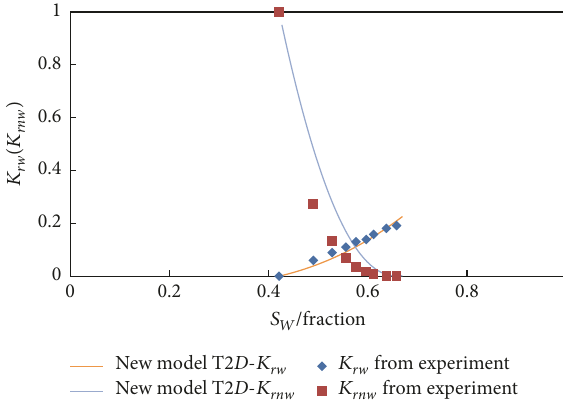
Figure 6: Transformation result contrast of Sample